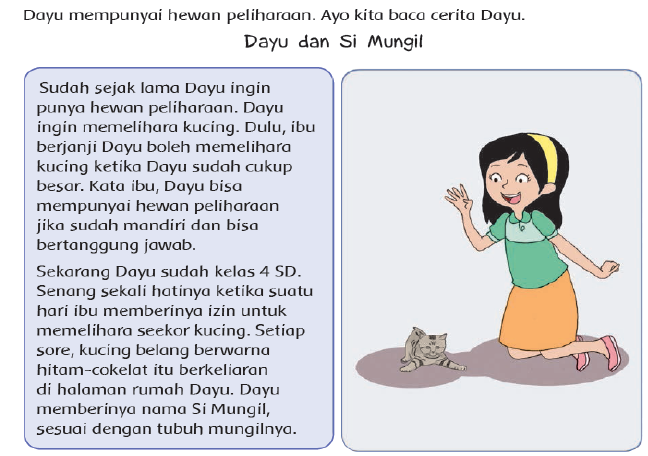
Figure 16: The story Dayu and Si Mungil